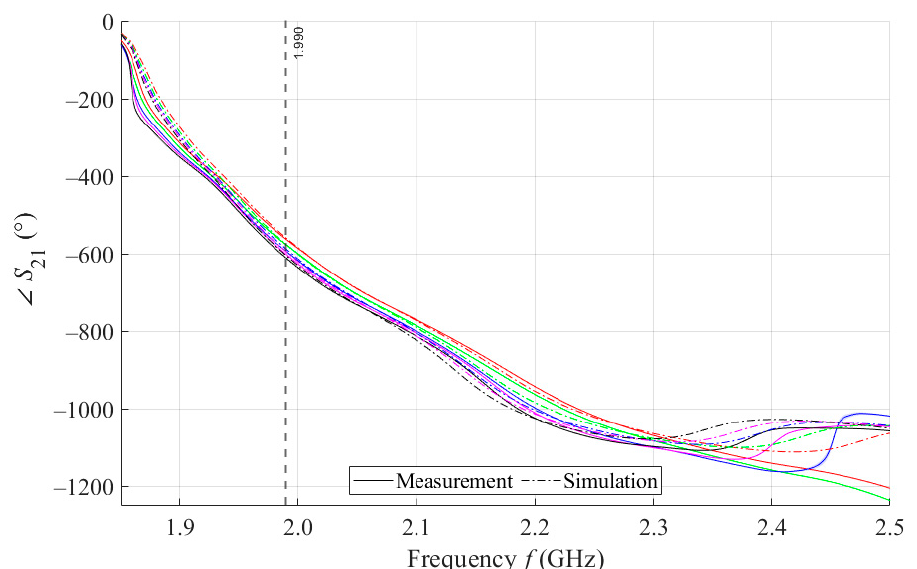
Figure 9. The course of ∠ S 21 for MTM9 and 4 mL.